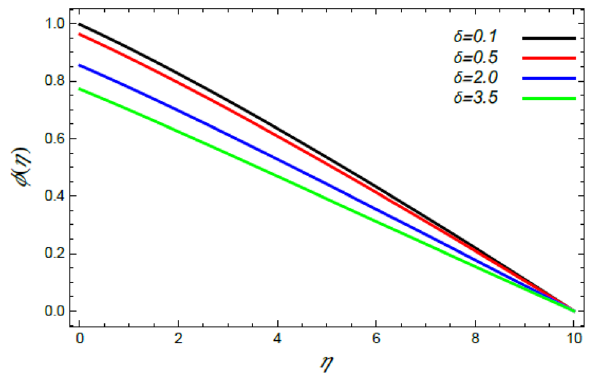
Figure 21. Deviation of the nanoparticle profile ϕ(η) versus η as given in Eq. (67) to illustrate the impact of the slip factor δ .